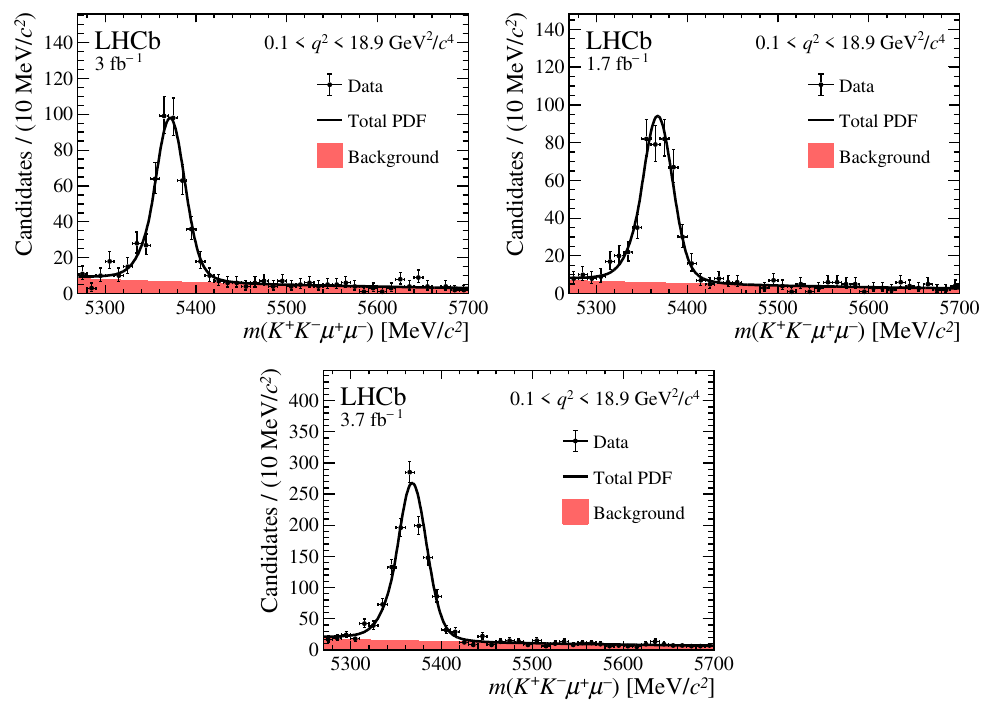
Figure 1 . The m ( K + K − µ + µ − ) distribution for B 0 → φµ + µ − candidates integrated s over the 0 . 1 < q 2 < 0 . 98 GeV 2 /c 4 , 1 . 1 < q 2 < 8 GeV 2 /c 4 , 11 . 0 < q 2 < 12 . 5 GeV 2 /c 4 and 15 . 0 < q 2 < 18 . 9 GeV 2 /c 4 regions for the data-taking periods 2011–2012 (top left), 2016 (top right), and 2017–2018 (bottom). The data are overlaid with the PDF used to describe the m ( K + K − µ + µ − ) spectrum, fitted separately for each data